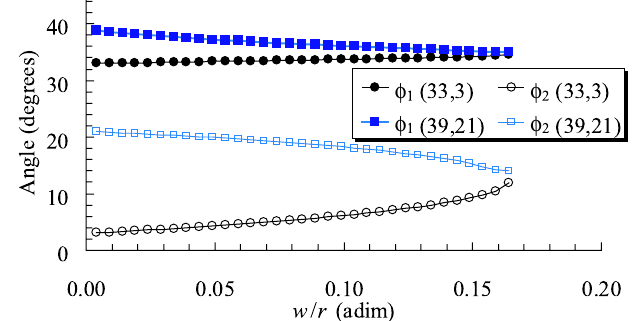
and B : 6 10 and (cid:12) versus 1 2